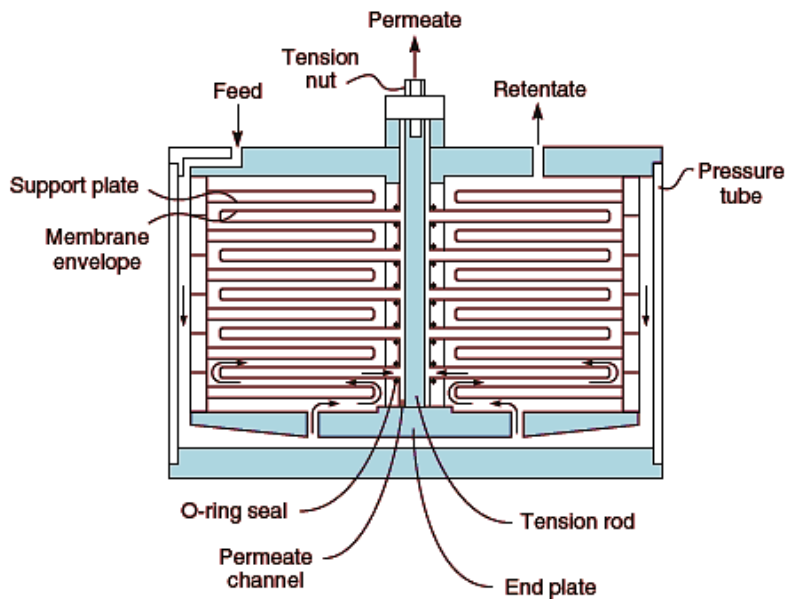
Figure 8. Plate and frame membrane module. Adapted from [13].